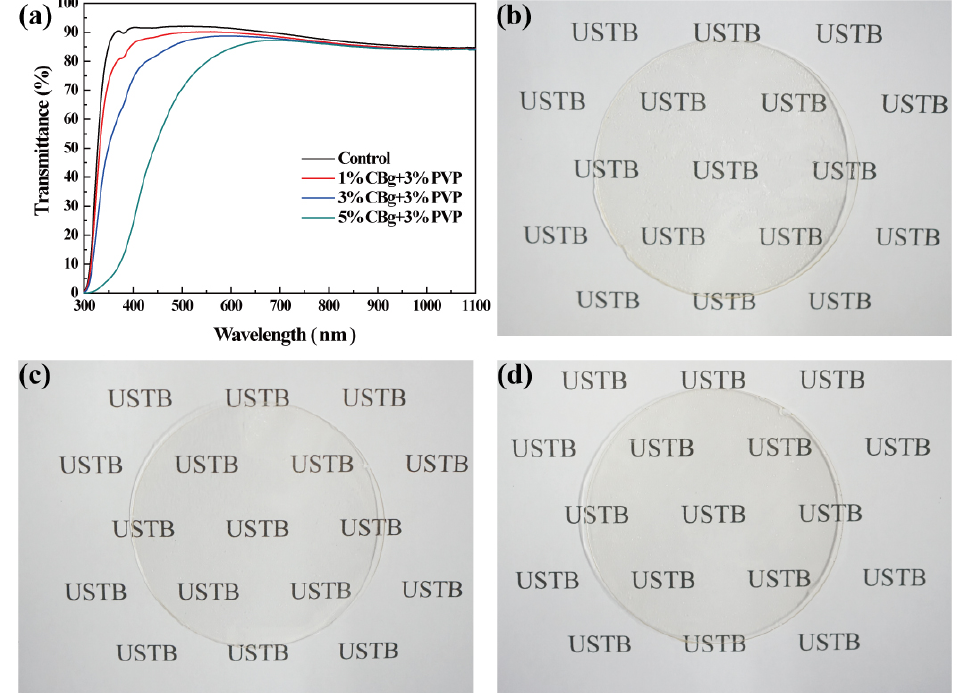
Figure 2. ( a ) UV-vis transmission spectrum of CBg/PVP films with different mass concentrations. Figure 2. ( a ) UV ‐ vis transmission spectrum of CBg/PVP films with different mass concentrations. Photographs of ( b ) 1CBg/PVP, ( c ) 3CBg/PVP, and ( d ) 5CBg/PVP films. Photographs of ( b ) 1CBg/PVP, ( c ) 3CBg/PVP, and ( d ) 5CBg/PVP